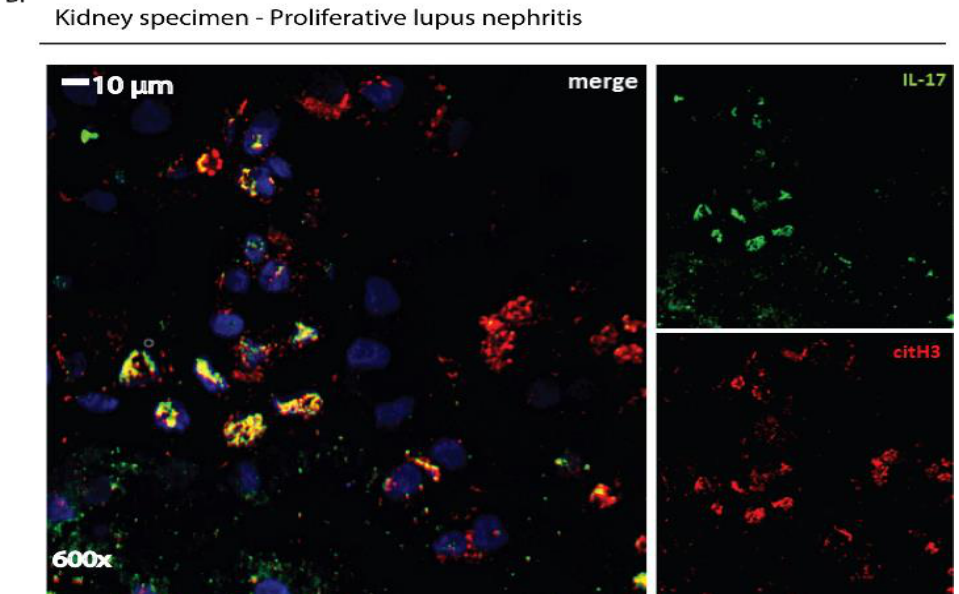
Figure 3. Immunofluorescence staining: a qualitative tool to detect NET remnants or disease-related proteins located on NETs in human tissue specimens. Cross-sections (4 µ m thickness) of kidney biopsy tissue derived from a patient with proliferative lupus nephritis (LN) were deparaffinized and stained with the appropriate antibodies. ( A ) NETs were visualized in kidney specimens as extracellular structures by staining with both a mouse anti-human neutrophil elastase ((NE), Abcam) antibody and a rabbit anti-human histone 3 (Anti-Histone H3 (citrulline R2 + R8 + R17), Abcam) antibody. ( B ) The presence of a disease-related protein on extracellular structures, such as IL-17 in LN, was examined using both a mouse anti-human IL-17A (R&D Systems) antibody and a rabbit anti-human histone H3 (Anti-Histone H3 (citrulline R2 + R8 + R17), Abcam) antibody. In ( A , B ), a goat anti-mouse AlexaFluor 488 antibody (Invitrogen) and a goat anti-rabbit AlexaFluor 594 antibody (Invitrogen) were used to detect primary antibodies. Sections were counterstained with DAPI and visualized in a confocal microscope (Revolution spinning disk confocal system; Andor, Belfast, UK). Data from the Molecular Hematology Laboratory archive are shown.